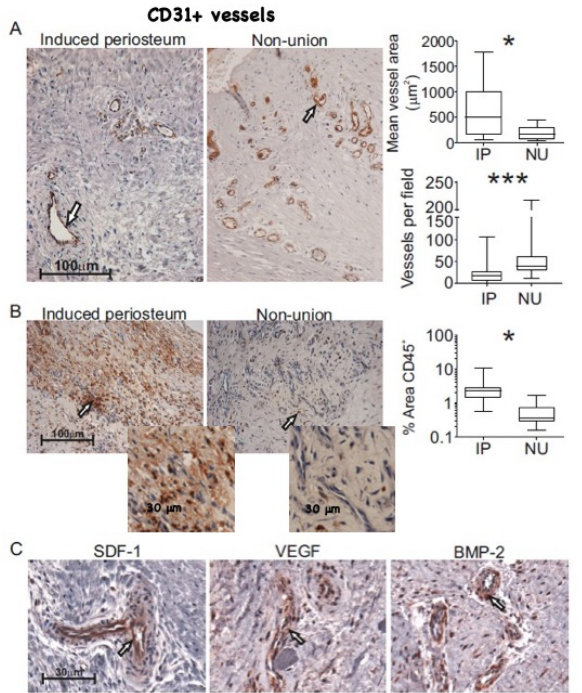
Figure 3. Histological examination of NU tissue. Comparison of blood vessel size highlighted by immunohistochemistry (IHC) staining for CD31 expression in induced periosteum (IP) and non-union (NU) tissue, representative photomicrographs (200 × magnification, scale bar 100 µ m) showing blood vessels (left and middle panels), comparison of mean internal vessel area by manual blind scoring (top right), and comparison of mean number of blood vessels per field (bottom right) ( A ). Comparison of leukocyte content highlighted by IHC staining for CD45 expression in IP and NU tissue, representative photomicrographs (200 × magnification, scale bar 100 µ m) showing leukocyte content (left and middle panels), and automated comparison showing the average area of positive staining per field (right) ( B ). Higher magnification images of CD45 + cells in IP and NU tissue are shown in the inserts. IHC staining highlighting perivascular location of stromal-derived factor-1 (SDF-1), vascular endothelial growth factor (VEGF), and bone morphogenetic protein-2 (BMP-2) in NU tissue (scale bar 30 µ m) ( C ). All data IP ( n = 8) and NU tissue ( n = 9), arrows show regions of positive staining (brown). * denotes p < 0.05, *** denotes p ≤ 0.001.